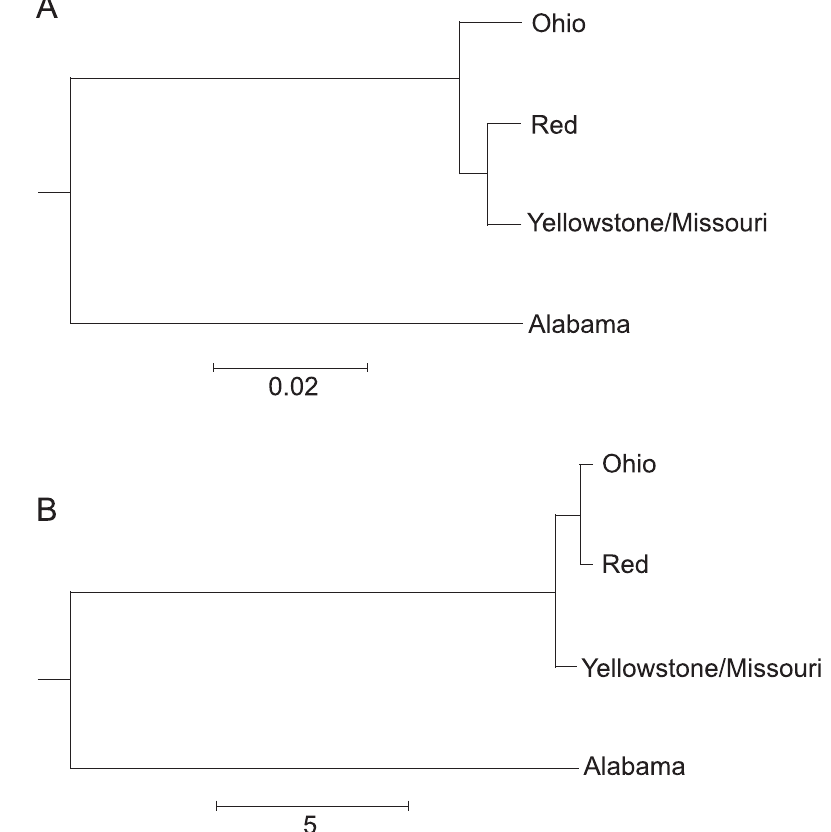
Fig. 2. UPGMA dendrograms based on F st ( A ) and distance ( B ) for four geographic populations of paddlefish, Polyodon spathula , at eight disomic microsatellite loci * Ramsey J.S. 1965. Zoogeographic studies on the freshwater fish fauna of rivers draining the southern Appalachian region. Doctoral dissertation. Tulane University, New Orleans,